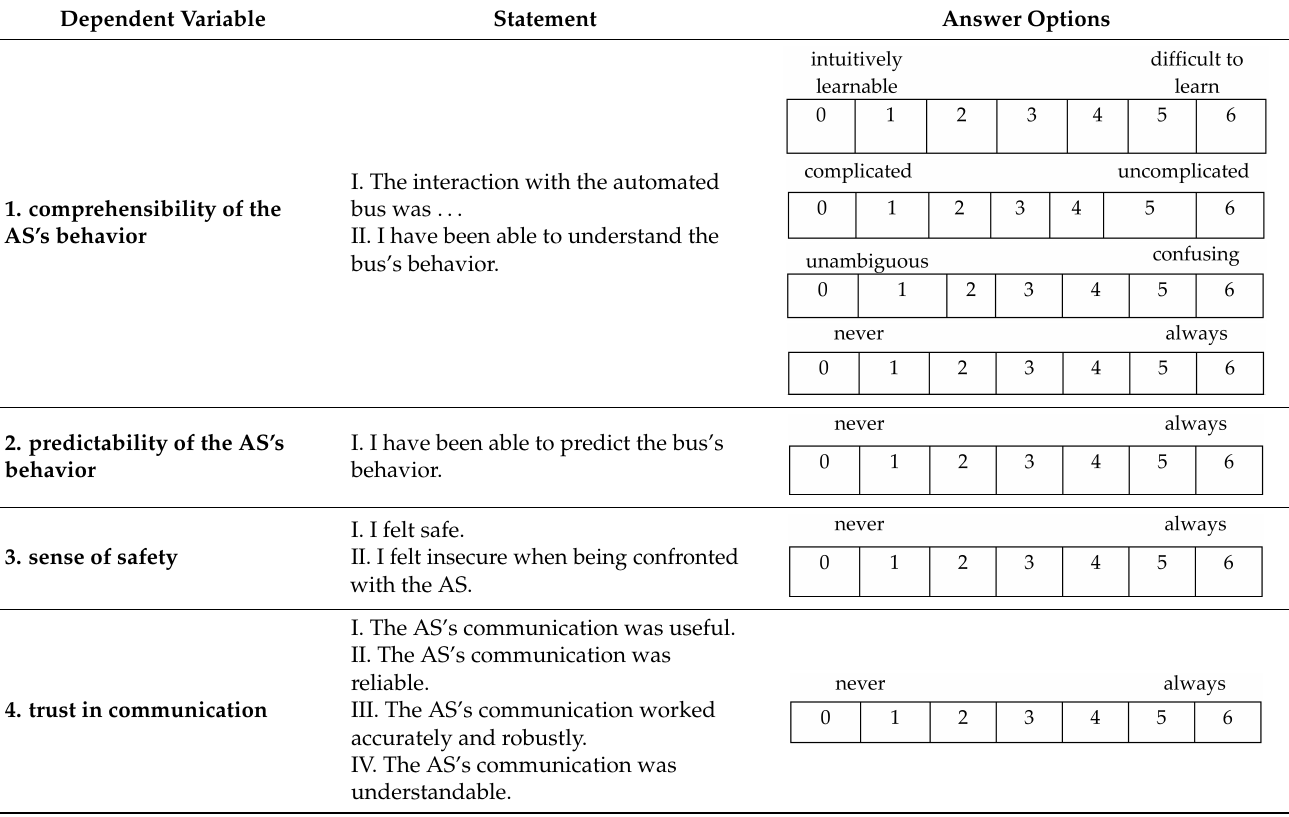
Table 2. Dependent variables and their operationalization in the